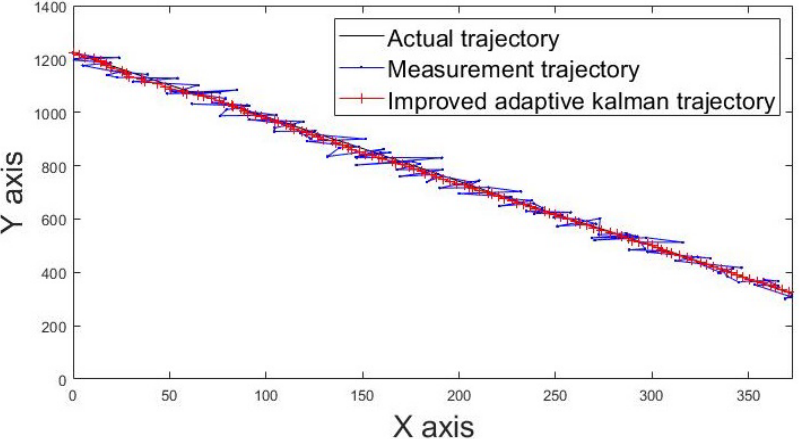
Figure 13. Movement trajectory 1 of tag.